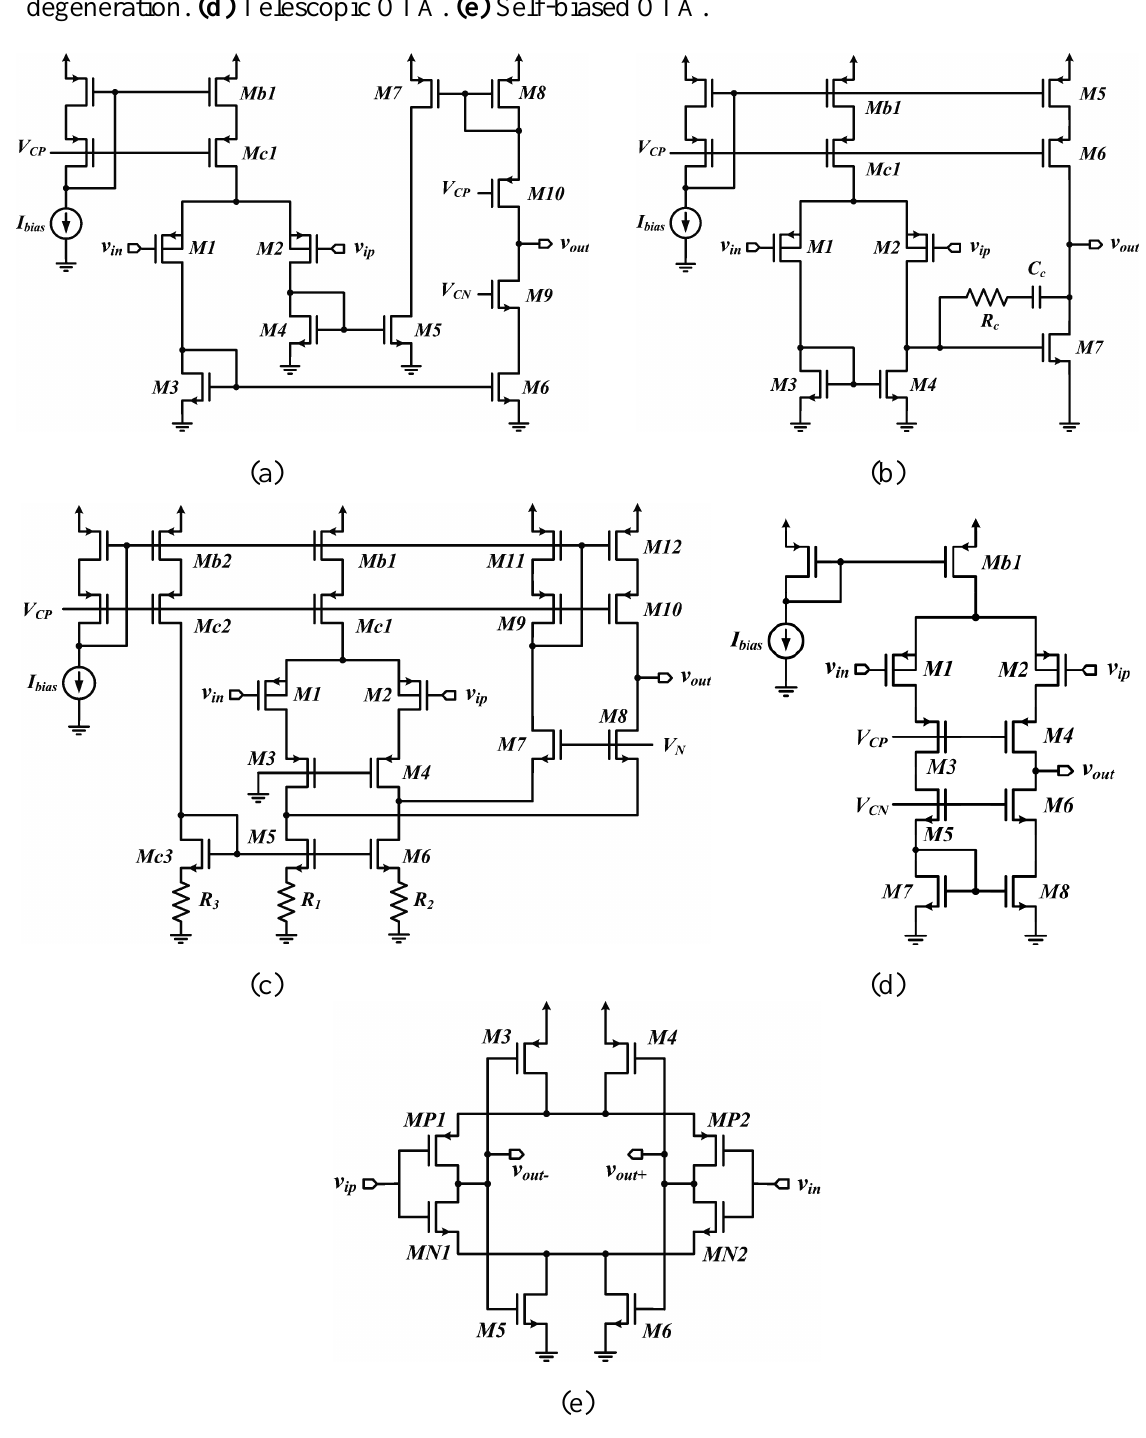
Figure 3. (a) Current-mirror OTA. (b) Miller OTA. (c) Folded OTA with source degeneration. (d) Telescopic OTA. (e) Self-biased